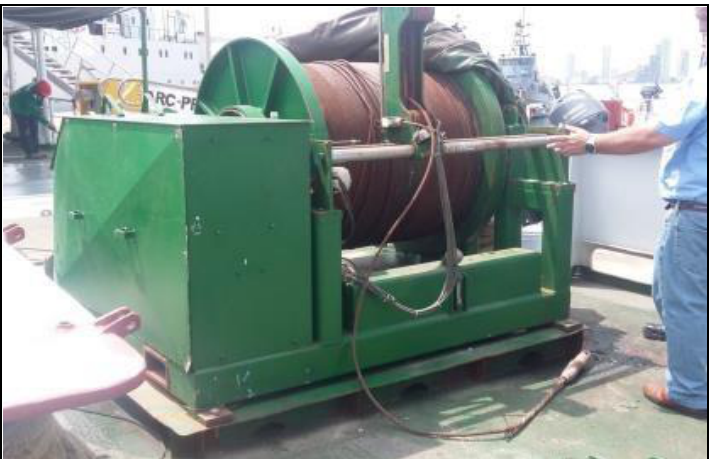
Figure 6. 2800 m geophysical research winch on board the ARC Providencia.